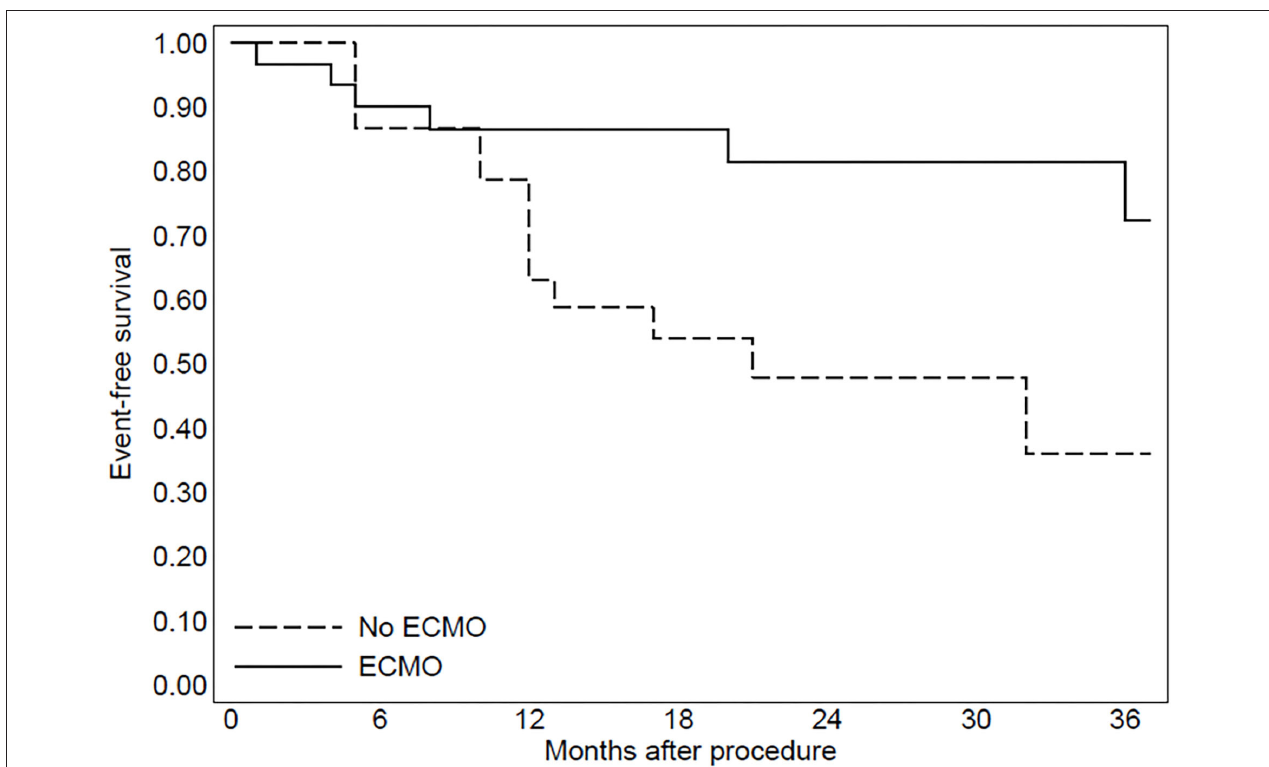
FIGURE 3 | The Kaplan-Meier curve to evaluate ICD interventions after the